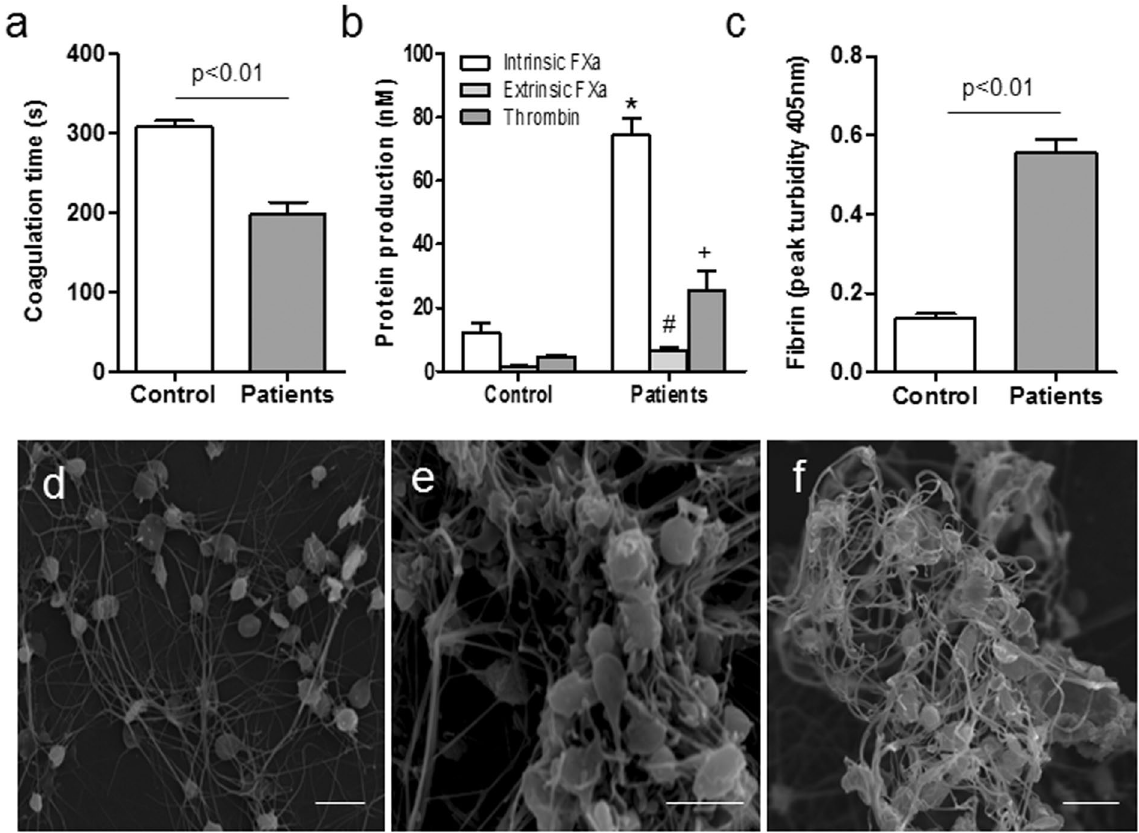
Figure 6. Coagulation dysfunction in septic patients. Platelets from patients (n = 15) were tested for ( a ) coagulation time, ( b ) intrinsic FXa, extrinsic FXa, thrombin formation, and ( c ) fibrin clot turbidity. Platelets from healthy individuals (n = 15) were used as controls. Scanning microscopy images of hypercoagulant platelets from patients showed ( d , e ) fibrin net and ( f ) microthrombus formation. Data represents mean ± SD; * # + P < 0.05 versus healthy controls. Bars represent 5 μ